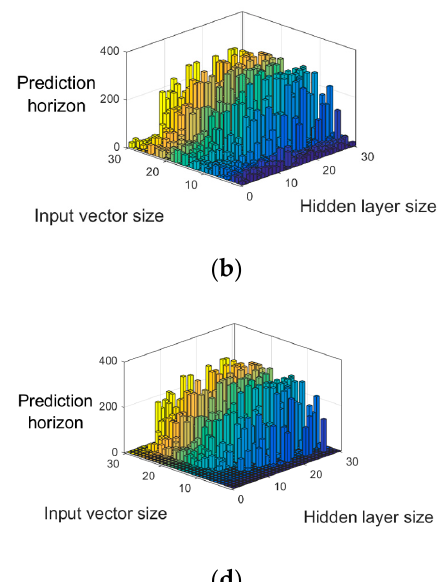
Figure 7. The simulation algorithm implemented in the MATLAB program.